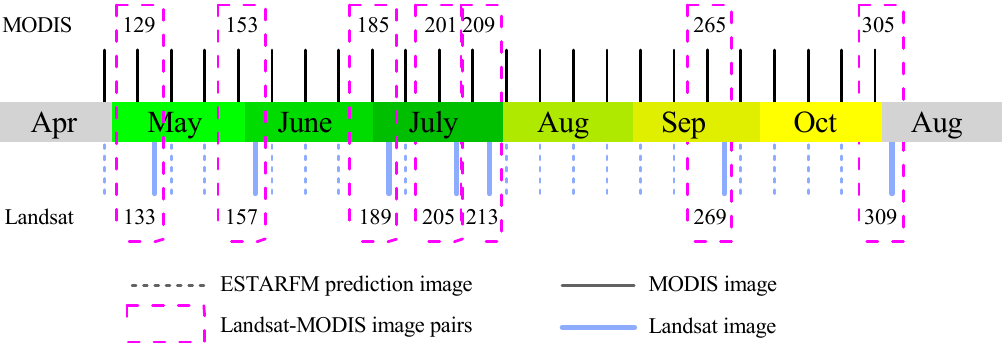
Figure 3. Date of MODIS, original Landsat images, and synthetic Landsat-like images by ESTARFM.